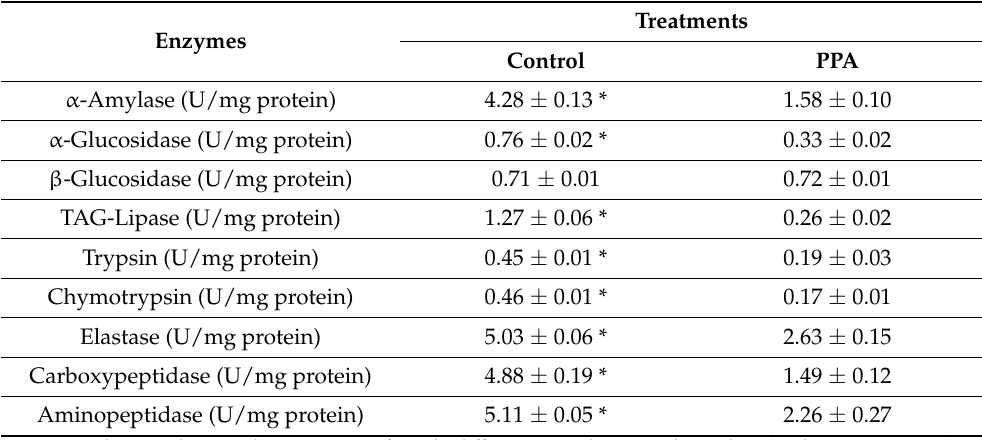
Table 2. Digestive enzymes’ activities in Sitophilus oryzae adults treated with sub-lethal concentration of PPA (LC 30 =